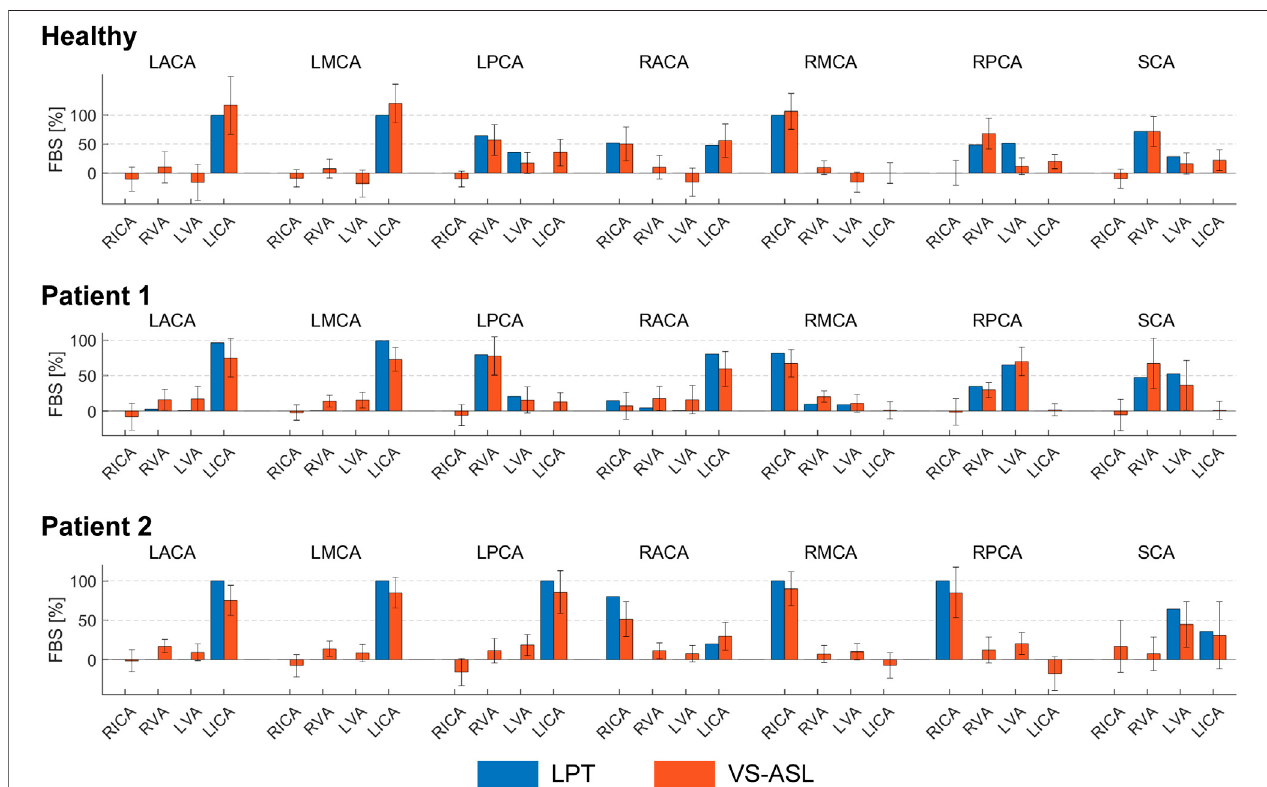
FIGURE5| ComparisonoftheFBS j,k ,obtainedfromVS-ASLandLPT,ineachvascularterritory j andforeachneckartery k .ForVS-ASL,valuesofFBS j,k represent themedianoftheFBS j,k distributionineachvascularterritory.Theerrorbarrepresentsthemedianabsolutedeviation.ForLPT,valuesofFBS j,k werecalculatedbasedon the particle count at each outlet of the CoW. RACA/LACA, right/left anterior cerebral artery; RMCA/LMCA, right/left middle cerebral artery; RPCA/LPCA, right/left posterior cerebral artery; SCA, superior cerebellar arteries; RVA/LVA, right/left vertebral artery; RICA/LICA, right/left internal carotid artery.